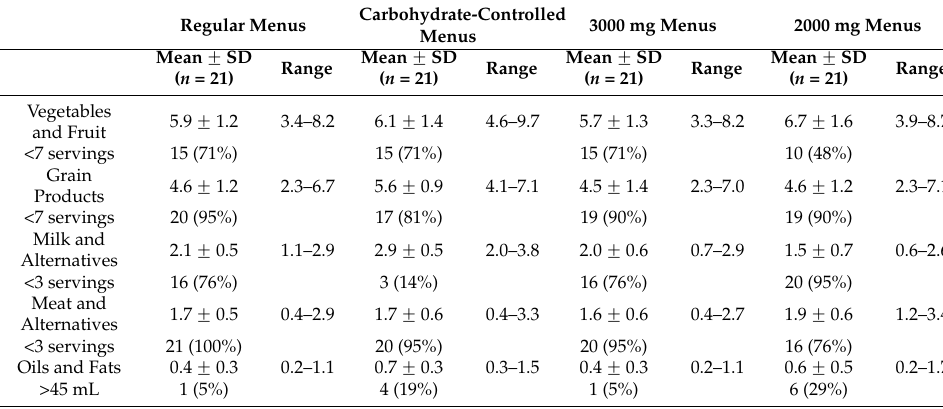
Table 2. Food group composition of regular, carbohydrate-controlled, 3000 mg Na and 2000 mg Na standard hospital menus [4].